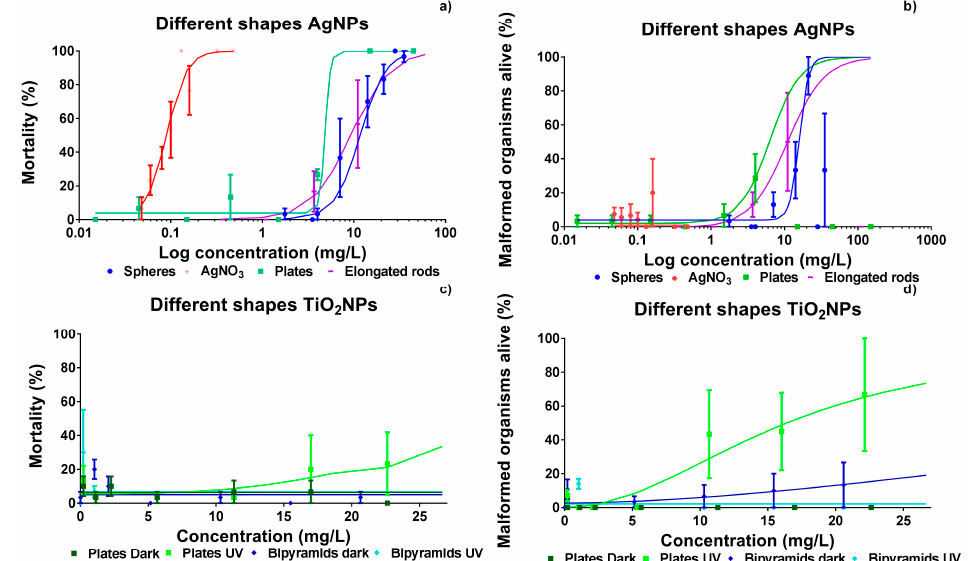
Figure 2. Dose–response curves for Ag NPs ( a , b ) and TiO 2 NP ( c , d ) based on mortality and on number of malformed organisms. The dose is expressed as the log-transformed actual total concentration at T independent replicates ± standard error of the mean